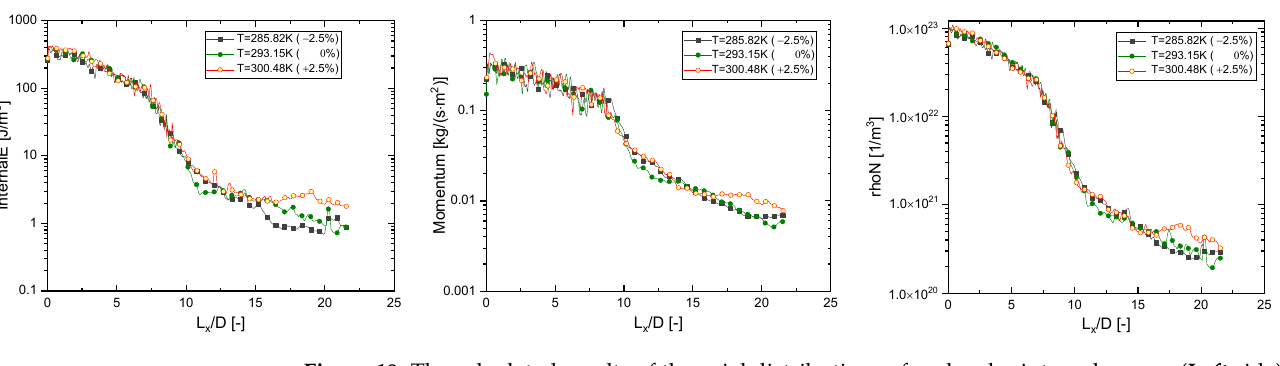
Figure 19. The calculated results of the axial distributions of molecular internal energy ( Left side), momentum ( Middle ) and molecular number density ( Right side) under different gas temperatures.